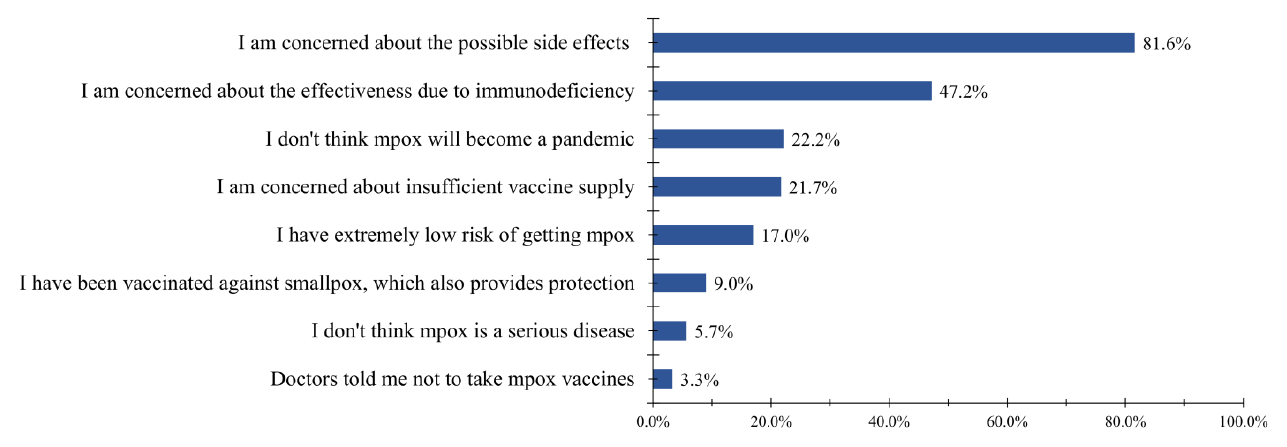
Figure 2. Reasons for unwillingness to get vaccinated against Mpox.